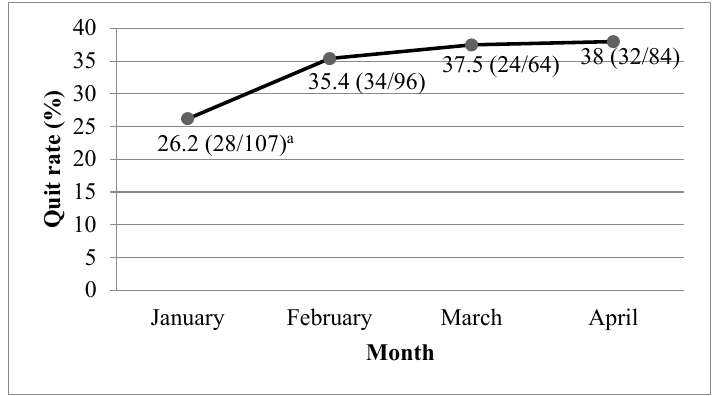
Figure 2. Quit rate among Youth Quitline participants by month. a Numerator = number of participants whose abstinence was biochemically validated; denominator = number of participants who completed follow-up.